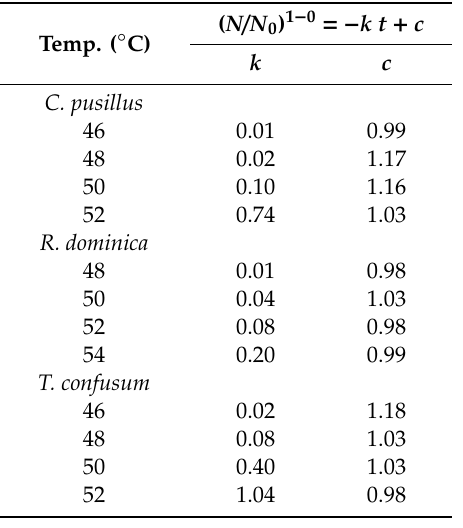
Table 2. Thermal death constants of 0th-order reaction model for C. pusillus , R. dominica , and T. confusum at four di ff erent temperatures.